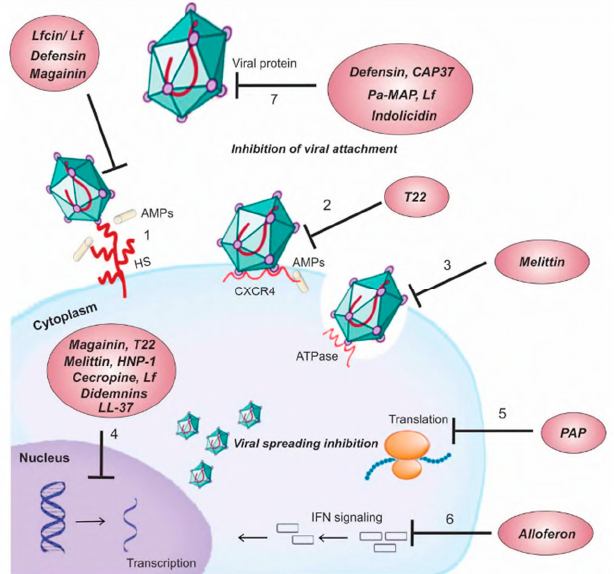
Figure 8. Summary of different mechanisms of action of cationic antiviral peptides from various sources (CAP37, LL-37, defensin, lactoferricin from humans, Alloferon, Melittin, Cecropin from insects, Didemnins from tunicate, Magainin from frogs, Pa-MAP from fish, PAP from plants, synthetic peptide, T22). Targets on the cell surface: (1) Peptide interactions with various glycosaminoglycans that compete with the virus for cellular binding sites. (2) The peptide stops the virus from getting into the cell by attaching itself to the viral receptor. (3) Avoiding cell fusion by preventing ATPase protein activity. Targets inside cells: (4) Prevention of viral gene expression, (5) ribosome inactivation to prevent peptide chain elongation, (6) induction of NK and IFN to activate an immune modulatory pathway. Viral protein targets: (7) Inhibition of adsorption/virus-cell fusion caused by peptide binding to viral proteins (reprinted with permission from Mulder et al., 2013